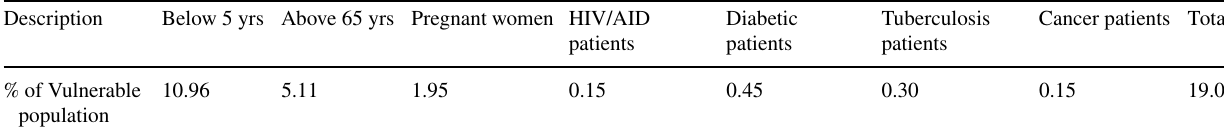
Table 8 Percentage of vulnerable population among people who consume untreated borehole water Description